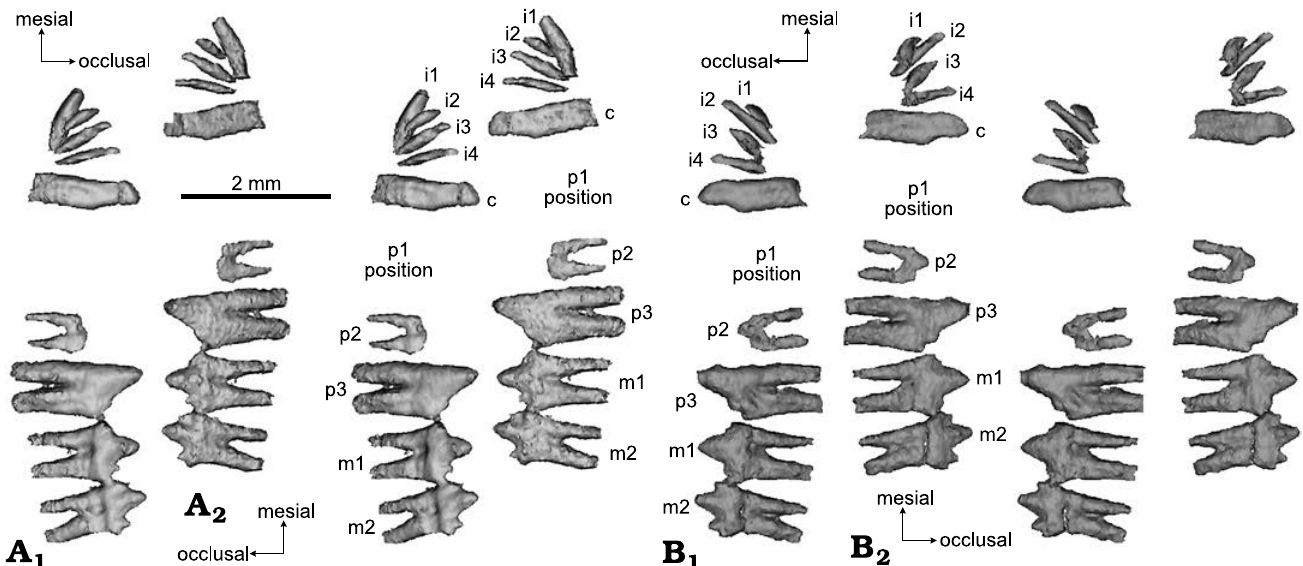
Fig. 8. CT rendering of mammaliaform Hadrocodium wui Luo, Crompton, and Sun, 2001 (holotype, IVPP 8275) from the Lower Lufeng Formation, Lower Jurassic of Yunnan, China. A . Left lower teeth (as preserved and virtually extracted from mandible): incisors, canine, incomplete premolars molars in labial (A 1 , stereopairs) and lingual (A 2 , stereopairs) views. The first premolar (p1) was shed and the vestige of its former alveoli recognizable on right mandible; penultimate premolar (p2) crown broken; ultimate p3 intact. B . Right lower teeth extracted by CT visualization, in labial (B 1 , stereopairs) and lingual (B 2 , stereopairs)